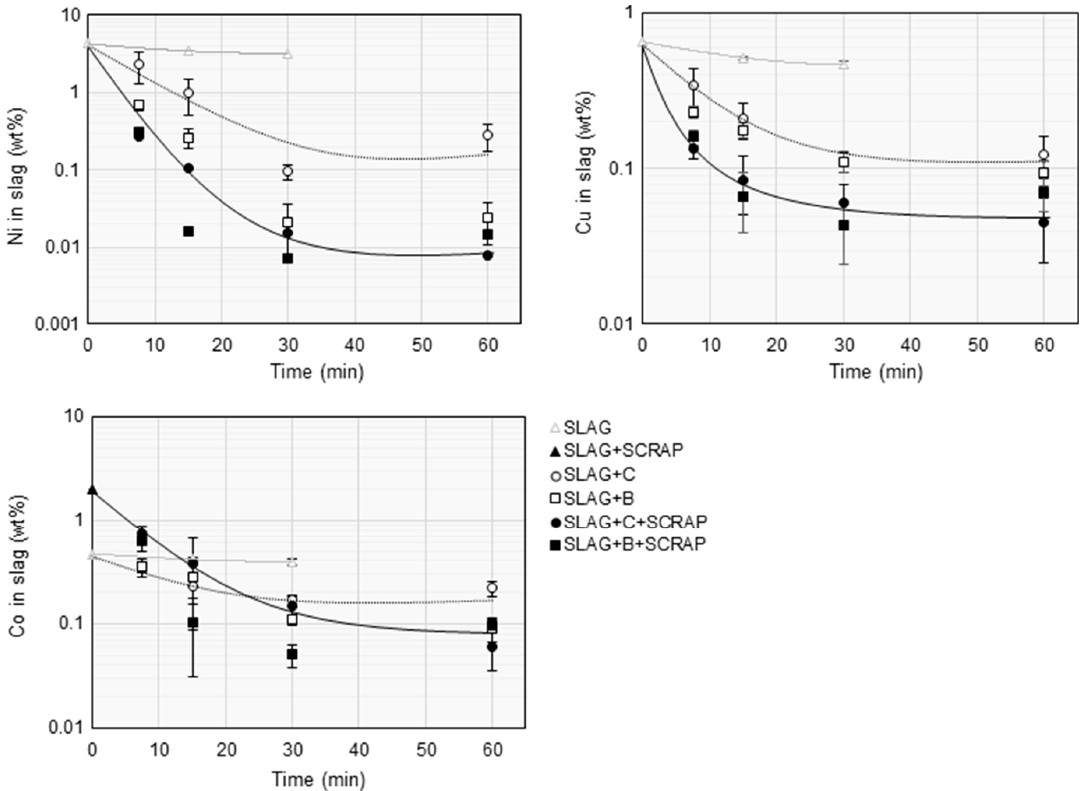
Figure 4. Nickel, copper and cobalt concentrations in slags as a function of reduction time at 1400 °C. The calculational concentration of cobalt in initial slag-scrap mixture (2 wt%) was added with symbol ▲ Trend lines were drawn for slag melting (SLAG as solid grey line (-)) and coke-containing reduction experiments (SLAG + C as dotted black line ( ∙∙∙ ) and SLAG + C + SCRAP as solid black line (-)).